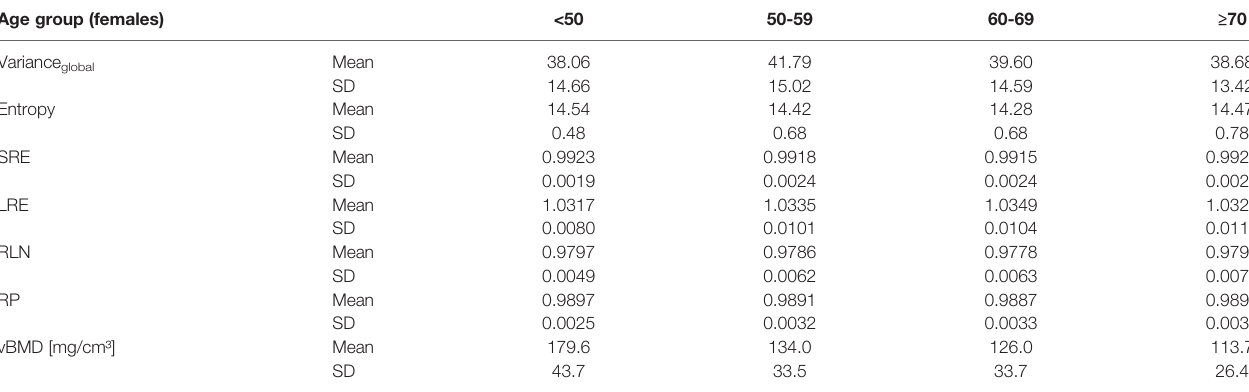
TABLE 6 | Mean and standard deviation (SD) of the six analyzed texture features and vBMD of females, grouped by age group. Age group (females)